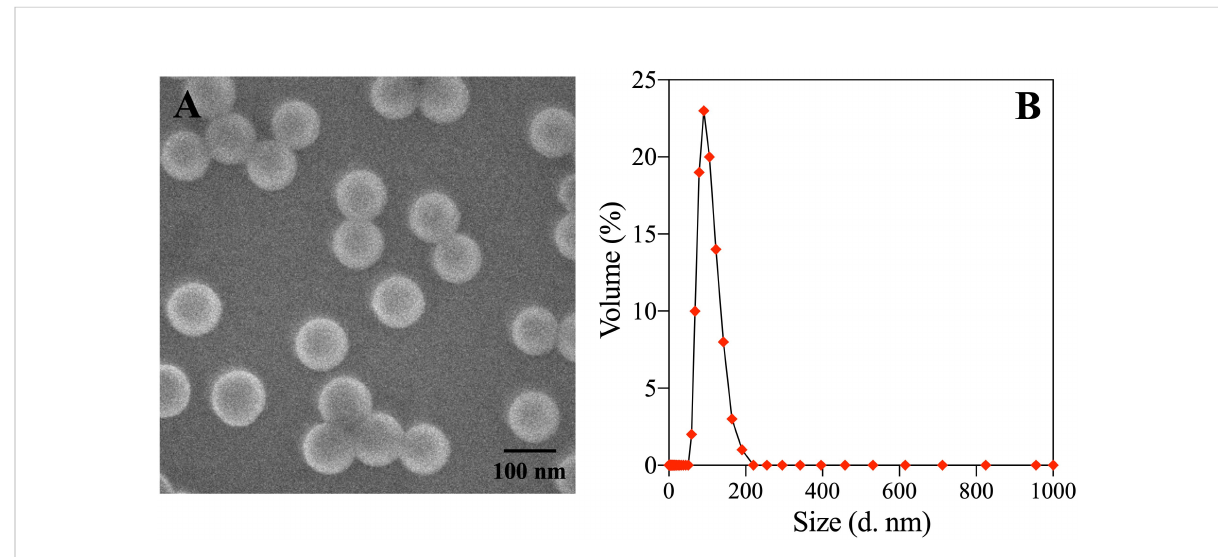
FIGURE 1 Scanning electron microscopy (A) and Hydrodynamic diameter distribution (B) Exposure of non-transgenic zebra fi sh